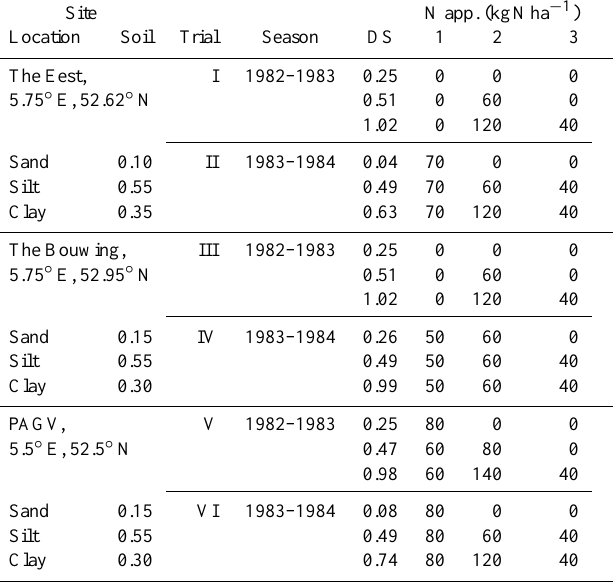
Table 1. Site- and treatment-specific data after Groot and Verberne (1991). For all trials (I–VI), three experiments with different appli- cations of N fertiliser were performed (1, 2 and 3). Their timing is expressed here by the development stage